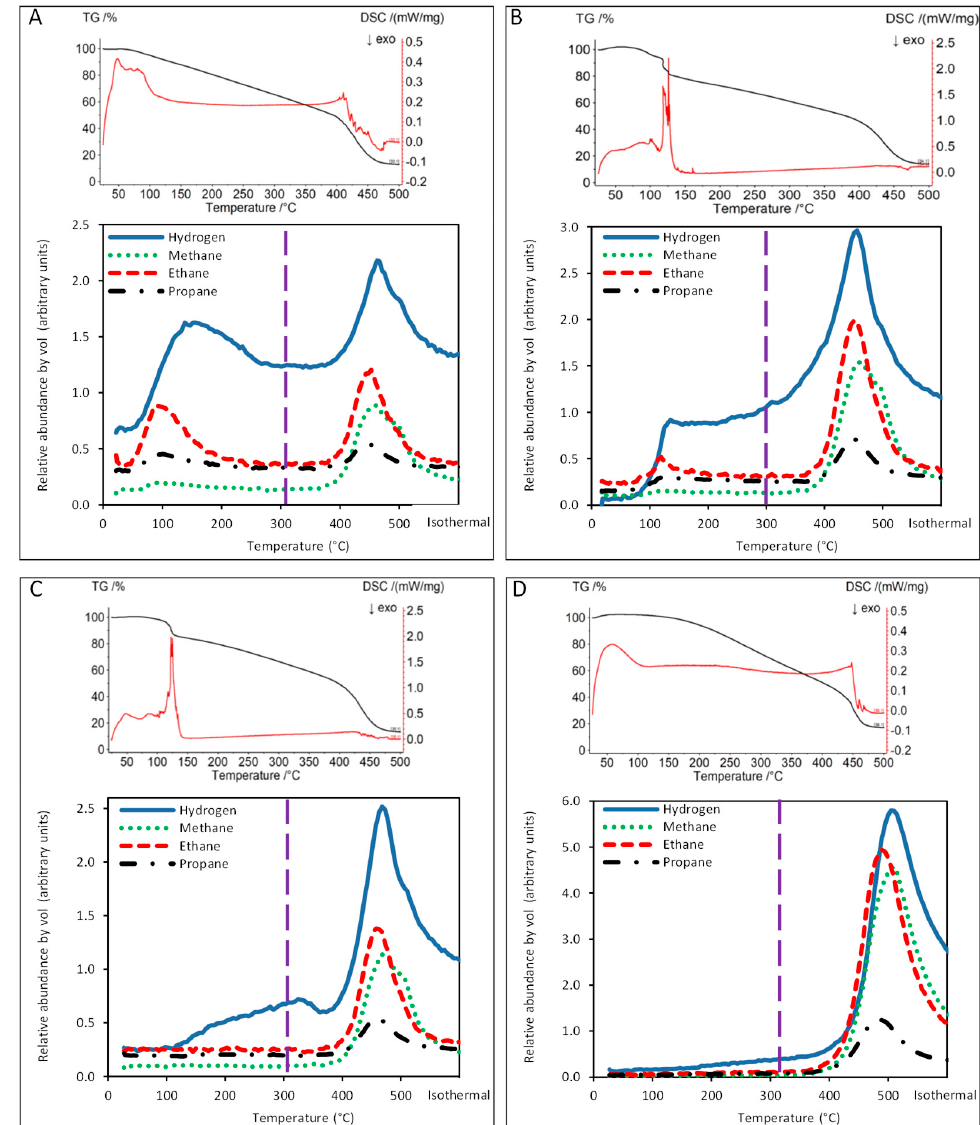
Figure 3. Pyrolysis of samples under moist carbon dioxide. Data for Diatomite Well 1312 ( A ), Orcutt Zones S2–S6 ( B ), Orcutt Zone S1B ( C ), and Grassy Creek #1 ( D ). Each panel contains TGA/DSC data (upper) and MS data (lower). Exothermic peaks in the DSC appear as negative peaks. The dashed vertical line at 300 ◦ C is to illustrate that pyrolysis is not expected below this temperature.